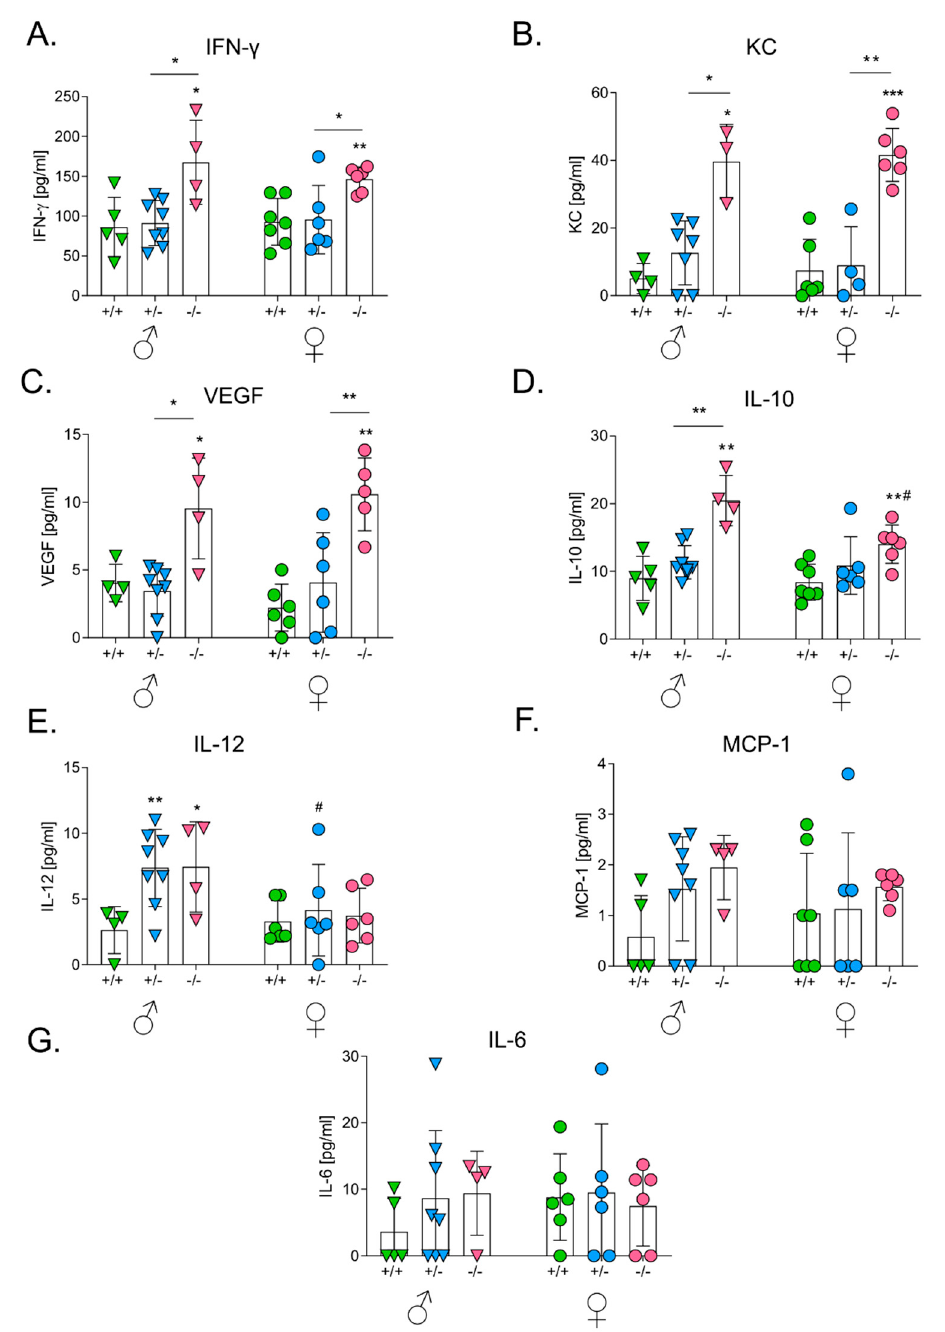
Figure 5. Effect of HO-1 expression in mice on concentrations of proangiogenic and proinflammatory cytokines in sera after intravenous injection with melanoma cells. ( A ) Concentration of IFN- γ . Cytometric analysis. ( B ) Concentration of KC. ELISA. ( C ) Concentration of VEGF. ELISA. ( D ) Concentration of IL-10. Cytometric analysis. ( E ) Concentration of IL-12. Cytometric analysis. ( F ) Concentration of MCP-1. Cytometric analysis. ( G ) Concentration of IL-6. Cytometric analysis. Each bar represents mean ± SE ( N = 3–8; * p < 0.05, ** p < 0.01, *** p < 0.001 vs. HO-1 +/+ mice, # p < 0.05, vs. ♀ ♂